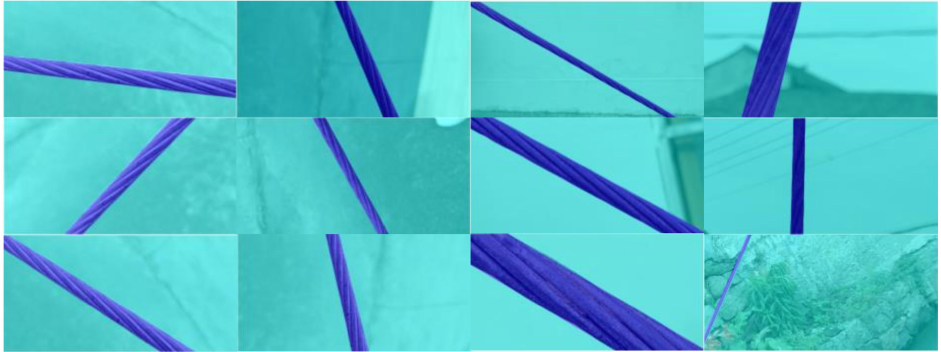
Figure 4. Annotated discrete images in training and validation set.